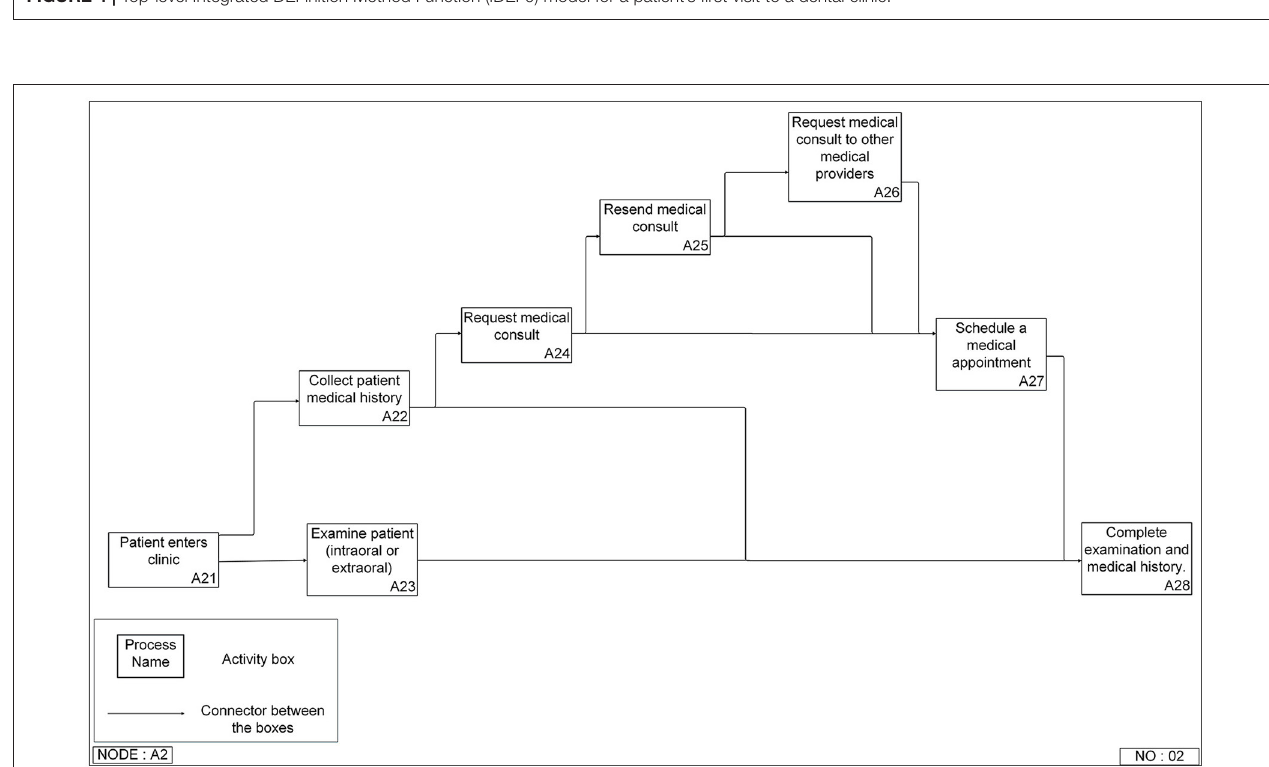
FIGURE 5 | Integrated DEFinition Method Function (IDEF0) model for patient-reported medical history with optional medical consults approach in a dental clinic setting that is not co-located with a medical clinic setting or uses an electronic dental record system.